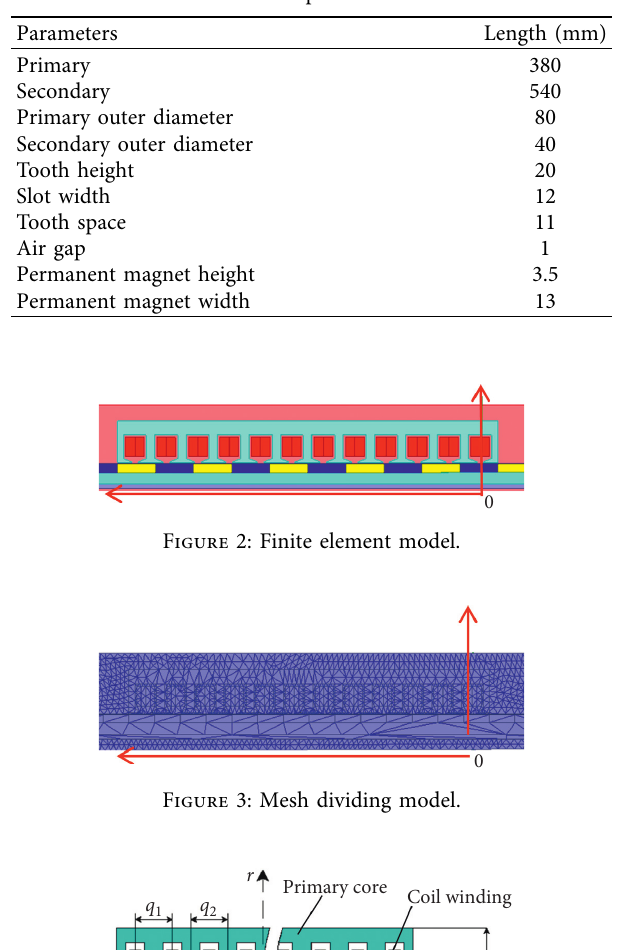
Table 2: Main structural parameters of the actuator.